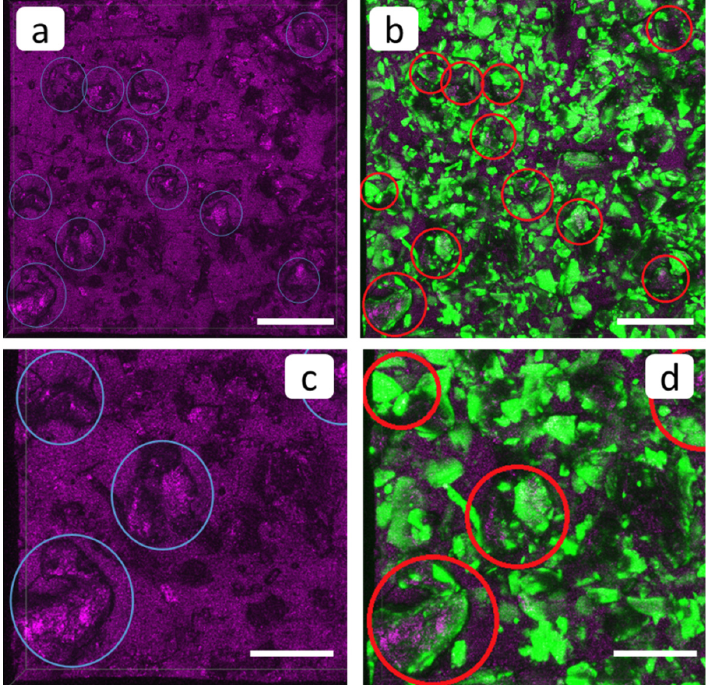
Figure 9. FM 3D images of the cation-exchange membrane MK-40 observed after the experiment run in the presence of PAA-F2, reflected light channel ( a , c ) and as a superposition of fluorescent and reflected light ( b , d ). Scale bar: 100 µ m ( a , b ) and 50 µ m ( c , d